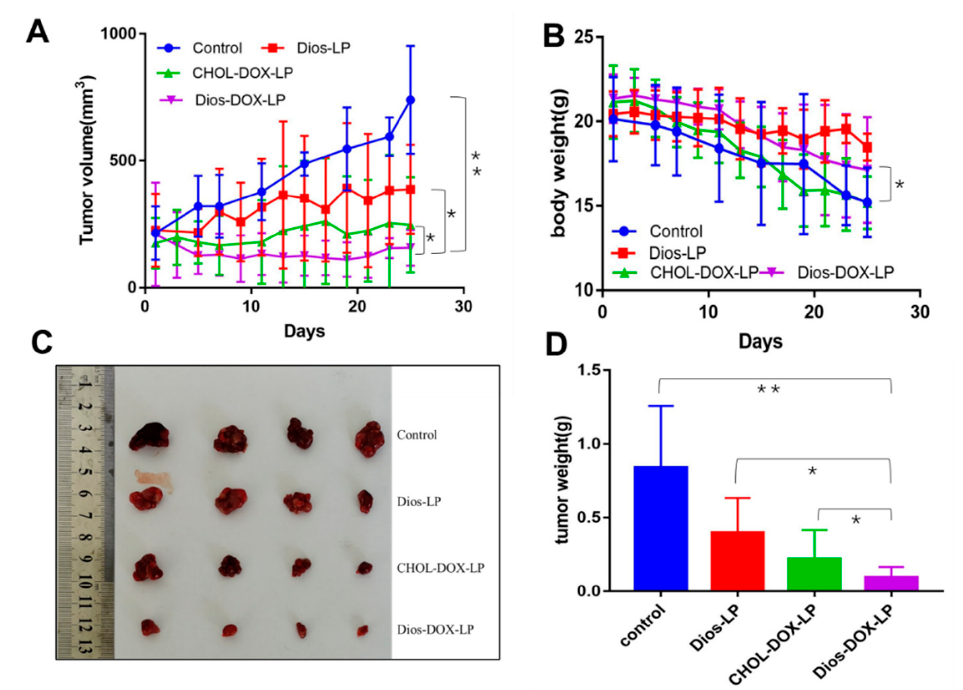
Figure 9. ( A ) Tumor volume changes in each group; ( B ) Body weight change in each group; ( C ) Tumor size in each group; ( D ) Tumor weight of each group. *: there was significant difference, p < 0.05; **: there was significant difference, p < 0.01 (n = 4).